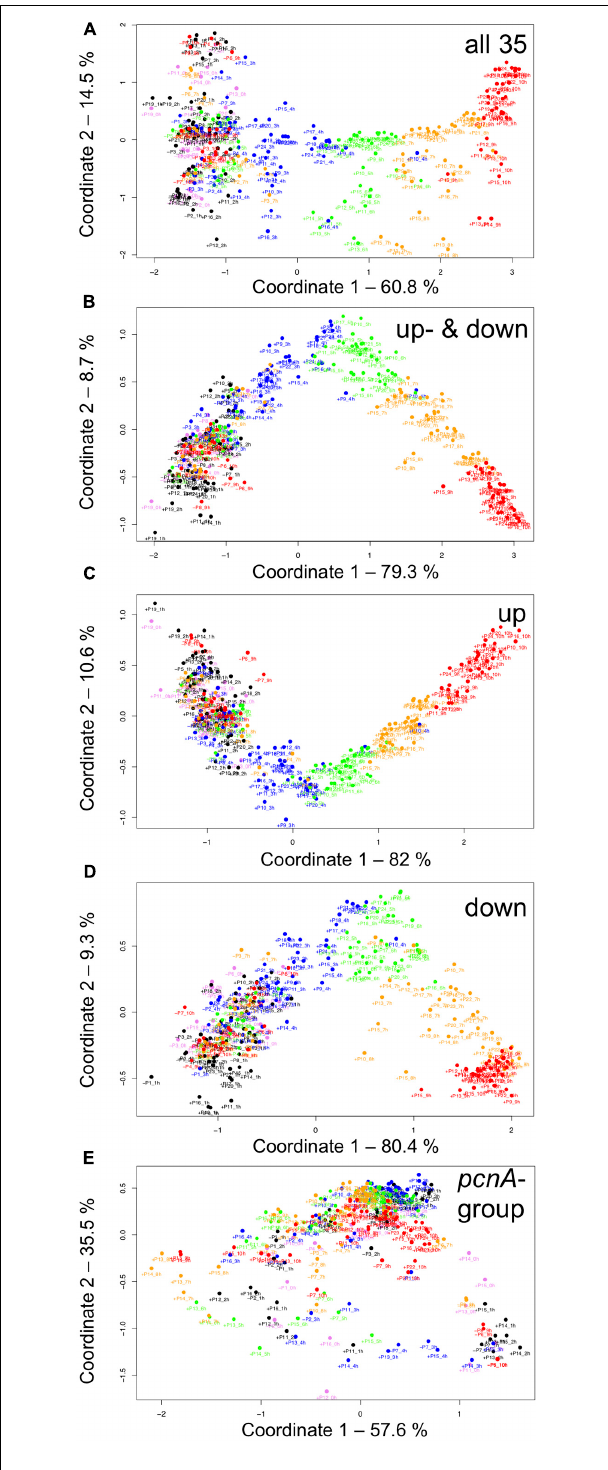
FIGURE 4 | Gene expression patterns of all analyzed cells displayed for different sub sets of genes. Multidimensional scaling was performed for the complete set of 35 genes (A) , the subset of the up- and the down-regulated genes (B) , or exclusively for up-regulated (C) , down-regulated (D) or the pcnA -group of genes (E) . Each data point represents the expression pattern